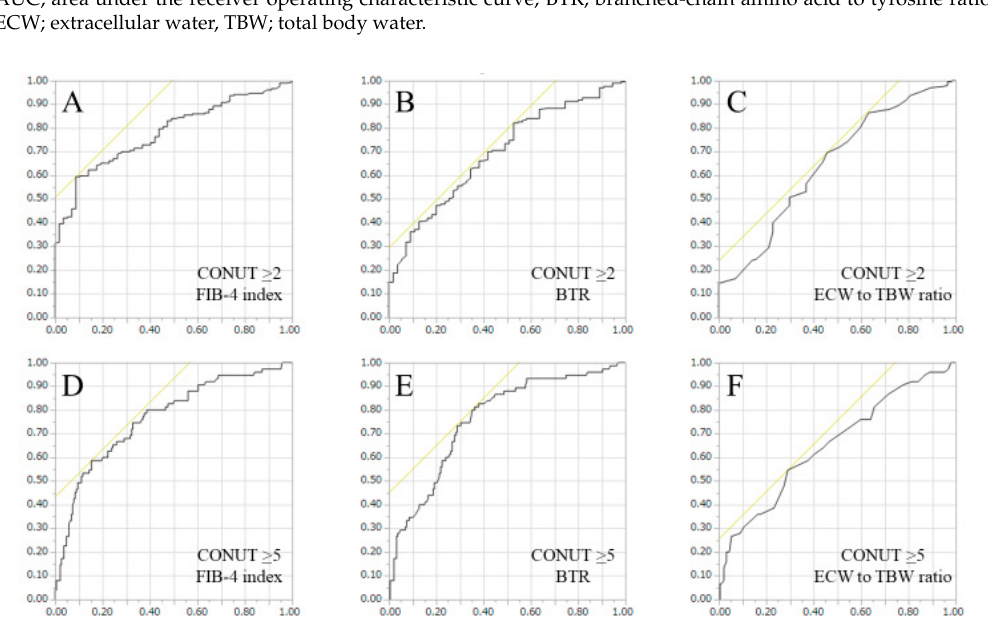
Figure 2. ROC curves for predicting CONUT score ≥ 2 or CONUT score ≥ 5. Horizontal axis indicates 1-specificity and vertical axis indicates sensitivity. Table 8. ROC analysis for predicting CONUT score ≥ 2 and CONUT score ≥ 5.